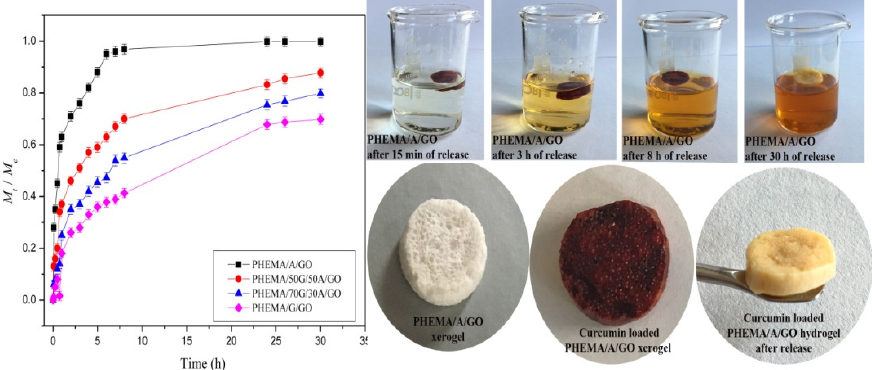
Figure 5. Curcumin release profiles from the hydrogels and photographs of unloaded, curcumin loaded and hybrid after the release of curcumin.